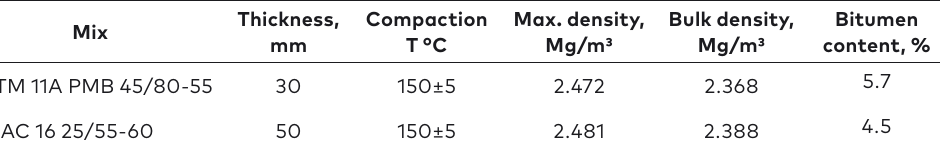
Table 1. Physical properties of the reference mixtures